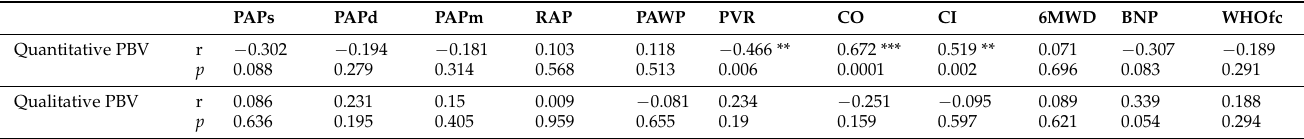
Table 2. Correlation analysis between lung perfusion blood volume (PBV) and hemodynamics pa- rameters. Top row: Pearson’s coefficients, Bottom row: Spearman’s coefficients.